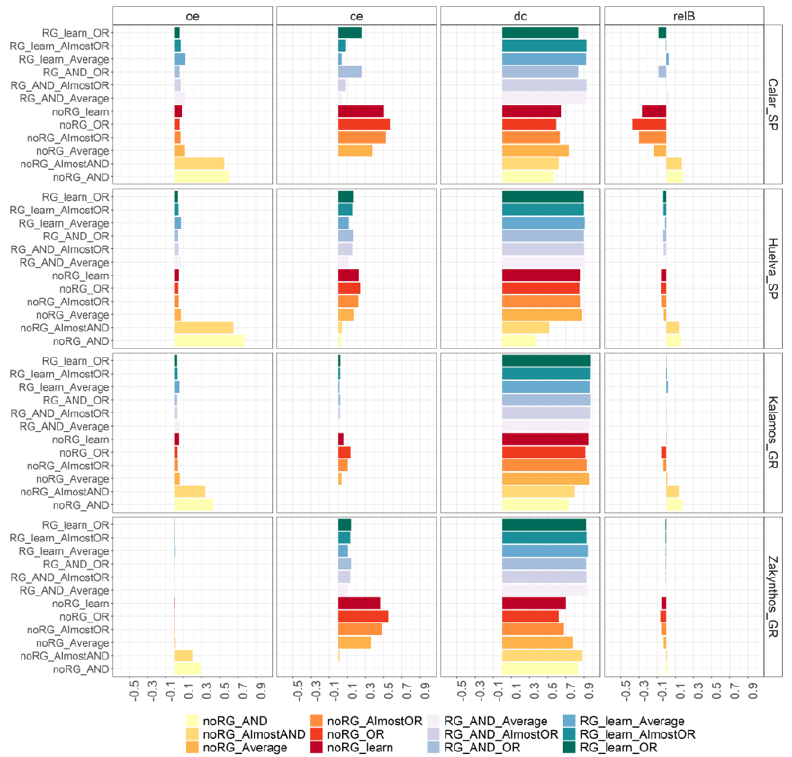
Figure 5. Accuracy metrics estimated for the four study sites for all combinations of OWAs with region growing (RG) and without region growing (noRG) (oe=omission error, ce=commission error, dc=dice coefficient, relB=relative